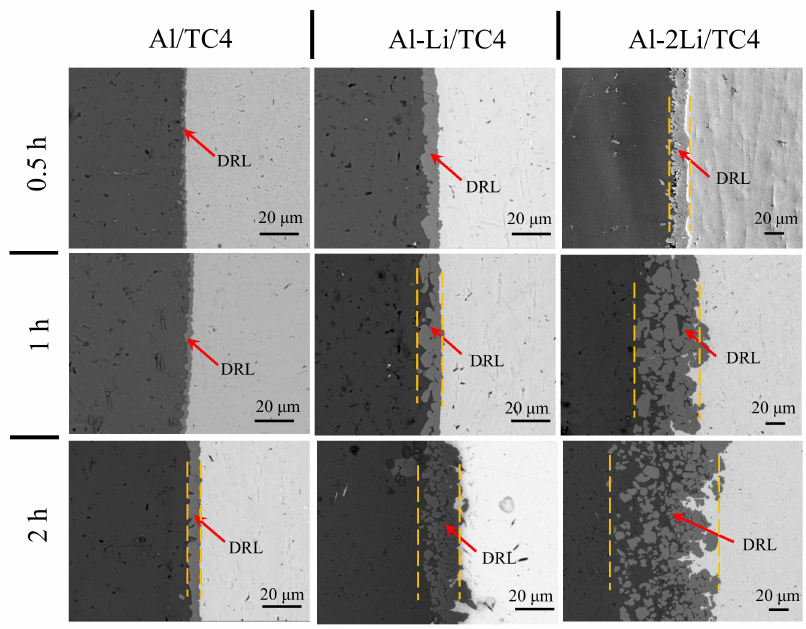
Figure 4. Influence of holding time and Li content of the melt on the micro-structural morphology at 700 ◦